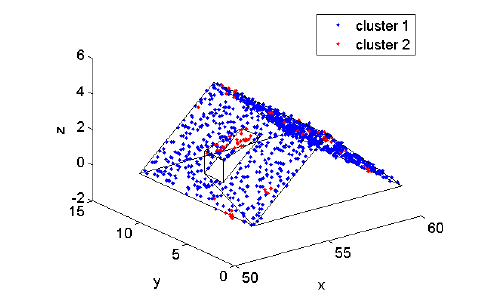
Figure 11. Point cloud clustering based on inclination and mean square error (MSE). Ridge points share the same cluster with dormer points.